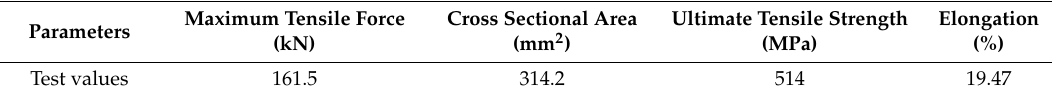
Table 1. Mechanical parameters of rock